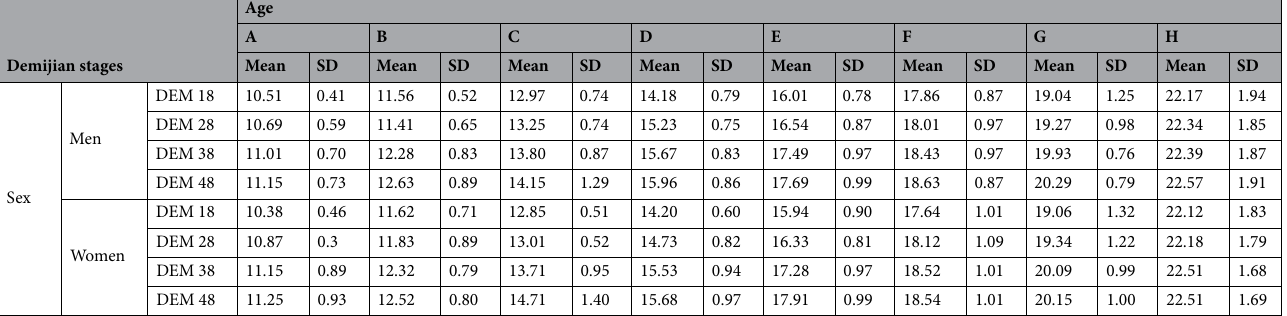
Table 3. Age according to Demirjian dental status by sex. SD standard